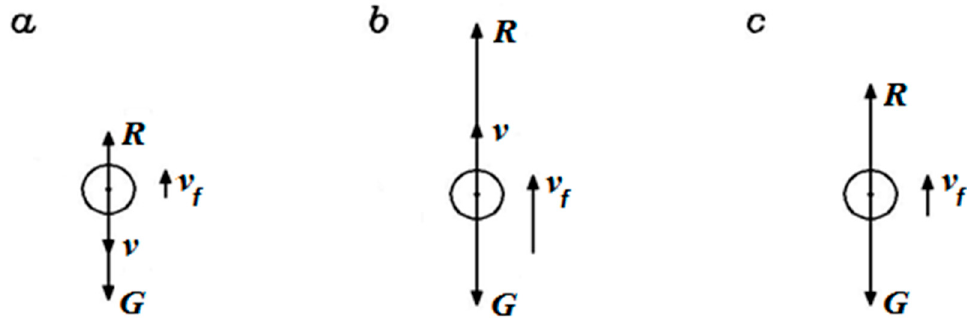
Figure 1. Forces acting on a particle in a vertical stream of air. ( a ) G > R; ( b ) G < R; and ( c ) G = R. The velocity of the fluid stream is denoted as v f .